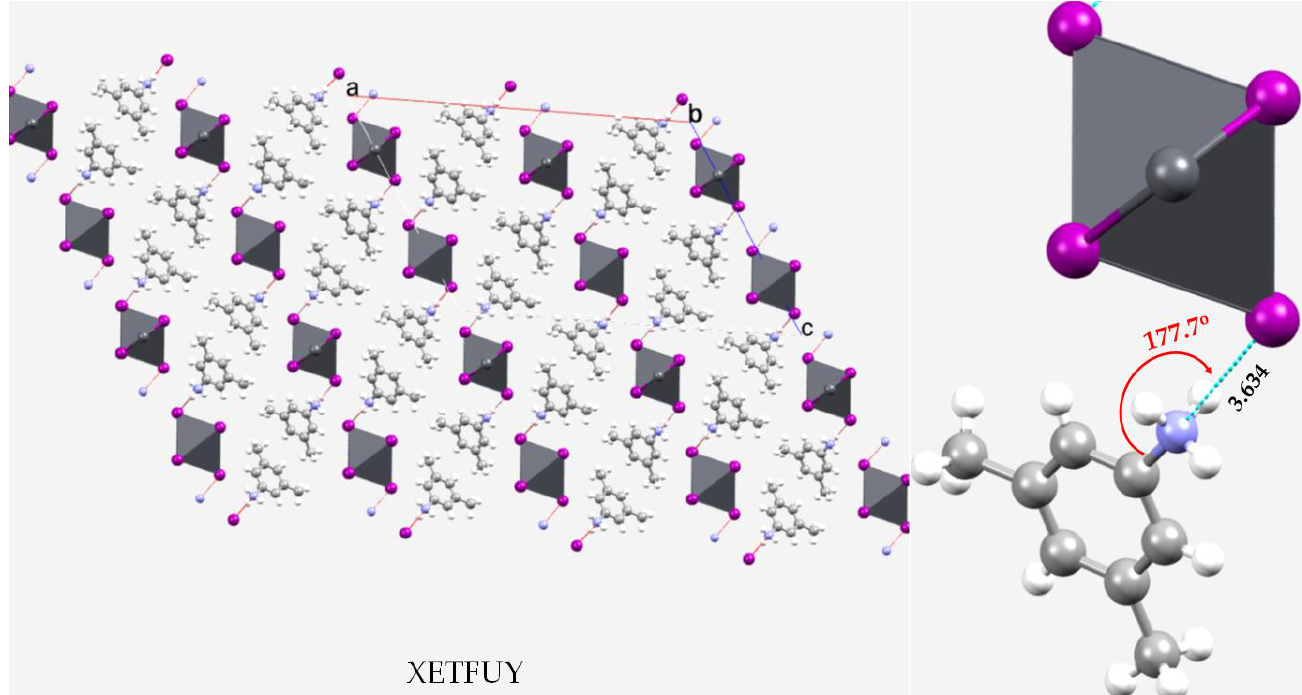
Figure 24. Ball-and-stick and polyhedral model of the 2 × 2 × 2 cell of the crystal of catena-(bis(3,5- dimethylanilinium) bis(μ 2 -iodo)-diiodo-lead(II)) [(C 8 H 12 N + ) 2 n , (I 4 Pb 2 − )] [159]. Intermolecular contacts between bonded atomic basins are illustrated as dotted lines in cyan and hanging contacts in red. Selected bond distance and bond angle associated with the nitrogen-centered pnictogen bond is in Å and degrees, respectively. The CSD reference is shown in uppercase letters.